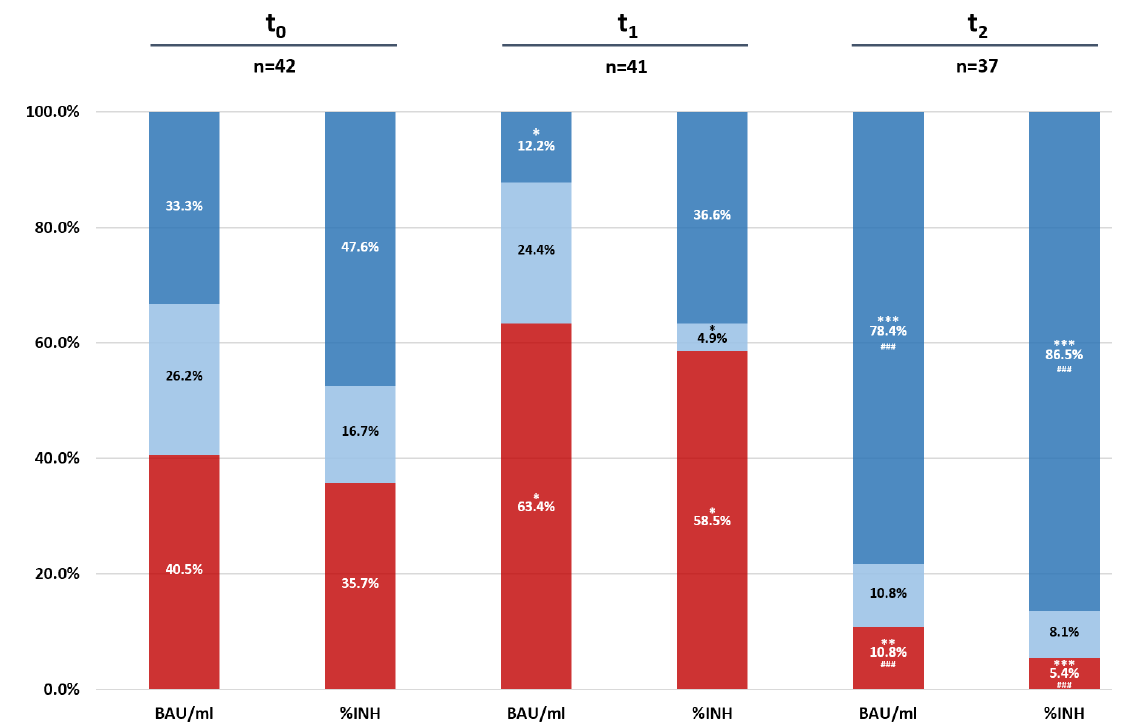
Figure 3. Proportion of patients with strong (dark blue: >500 BAU/mL or >70%-INH), moderate (light blue: 100–500 BAU/mL or 50–70%-INH) and no/low (red: <100 BAU/mL or <50%-INH) humoral response at the three different time points (t 0 , t 1 and t 2 ). Data are expressed as percentage. * p ≤ 0.05, ** p ≤ 0.01, *** p ≤ 0.001 compared to t 0 ; ### p ≤ 0.001 compared to t 1 .